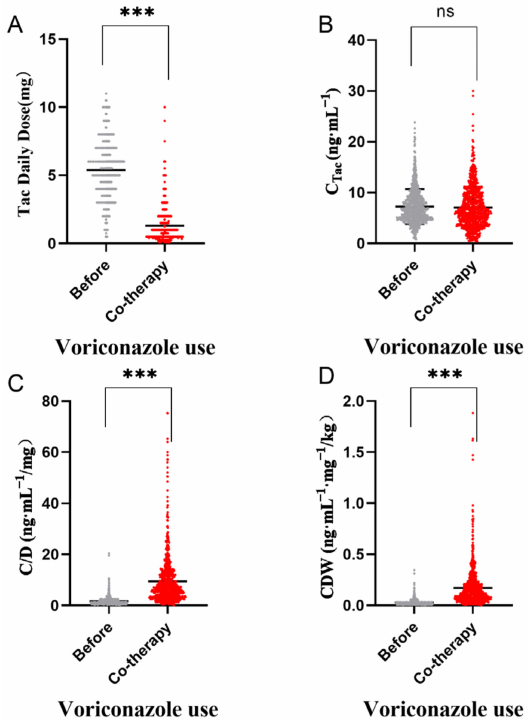
Figure 1. Effects of voriconazole use on tacrolimus daily dose ( A ), C Tac ( B ), C/D ( C ), and CDW ( D ). *** p < 0.001; p value was tested by Kruskal–Wallis test and adjusted by Dunn–Bonferroni correction; direct concentration (C Tac ), standard concentration adjusted by tacrolimus daily dose (C/D), and weight-adjusted standard concentration